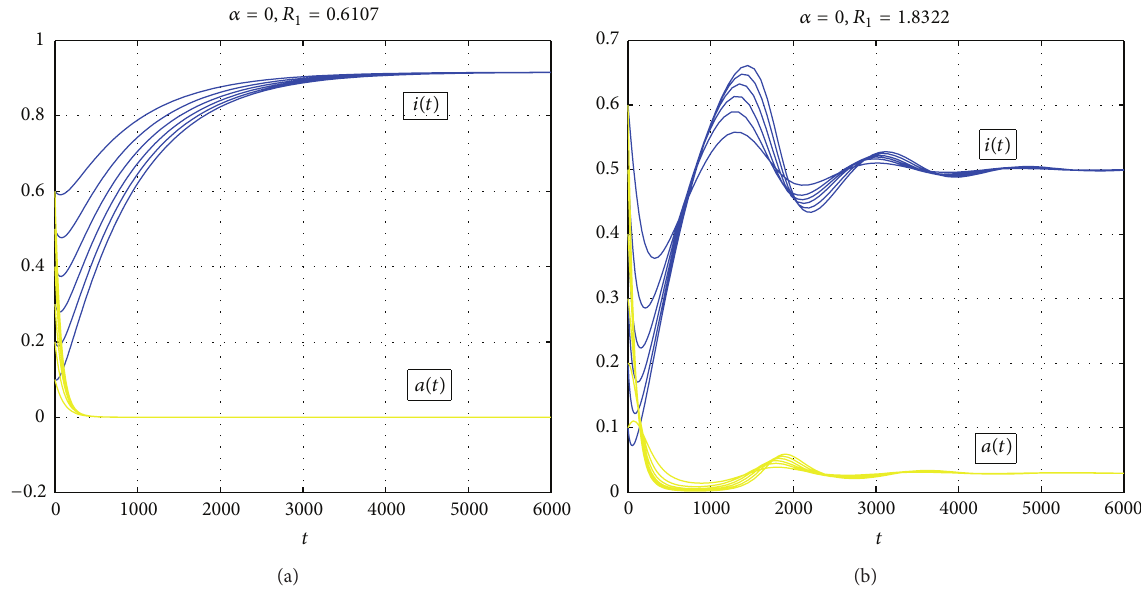
Figure 1: (a) and (b) are time series of system (3) when 𝛼 = 0